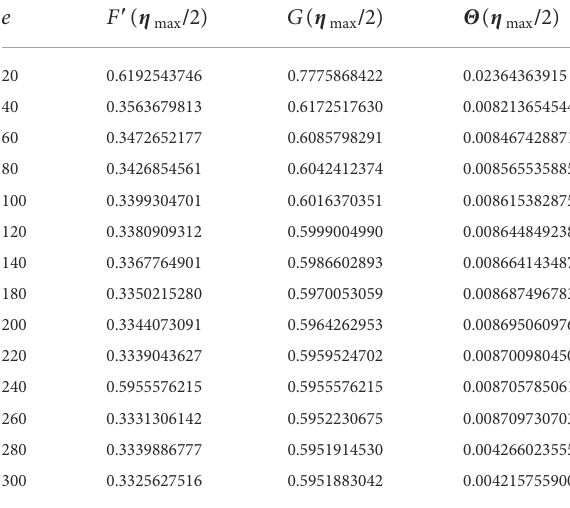
TABLE 2 Grid-independent investigation for G ( η max /2 ) , Θ ( η max /2 ) , and F 9 ( η max /2 ) .